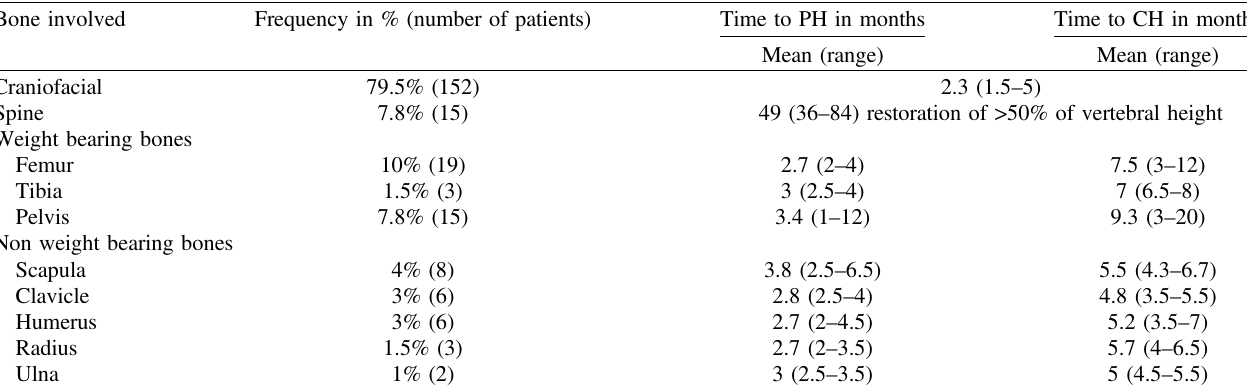
Table 3. Anatomic distribution of skeletal lesions, time to partial and complete